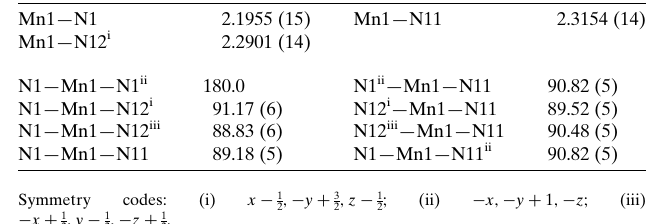
Table 1 Selected geometric parameters (A˚ , (cid:5)